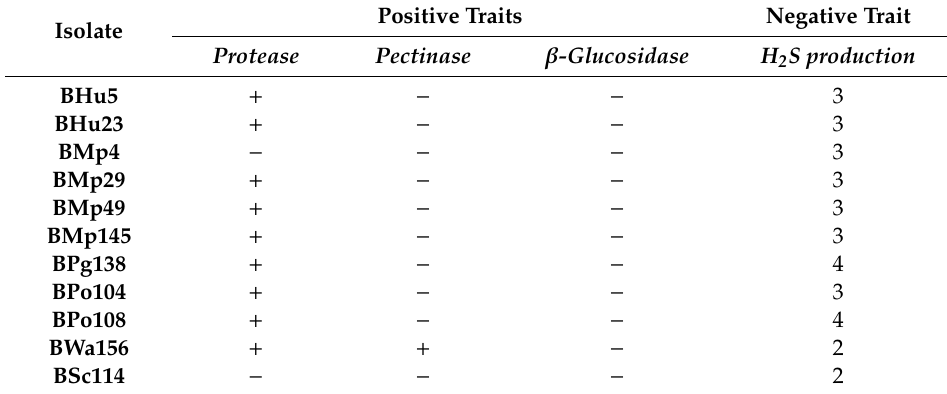
Table 4. Non- Saccharomyces